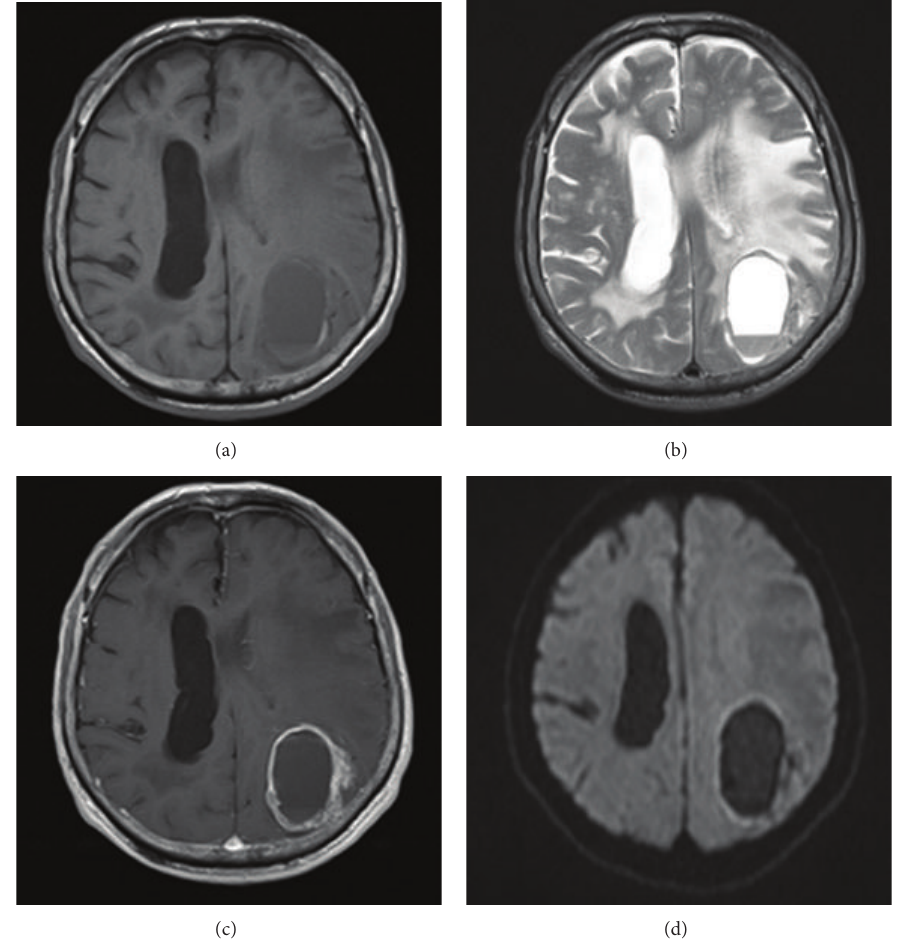
Figure 2: (a) Axial plain T1-weighted MR image shows homogeneous low-intensity area in the left temporal and parietal lobes. (b) Axial plain T2-weighted MR image shows a high-intensity area that indicates hemorrhage, a cyst, and marked peritumoral edema. (c) Diffusion-weighted image (DWI) shows low-intensity area not indicative of abscess. (d) Axial enhanced T1-weighted MR image shows ring